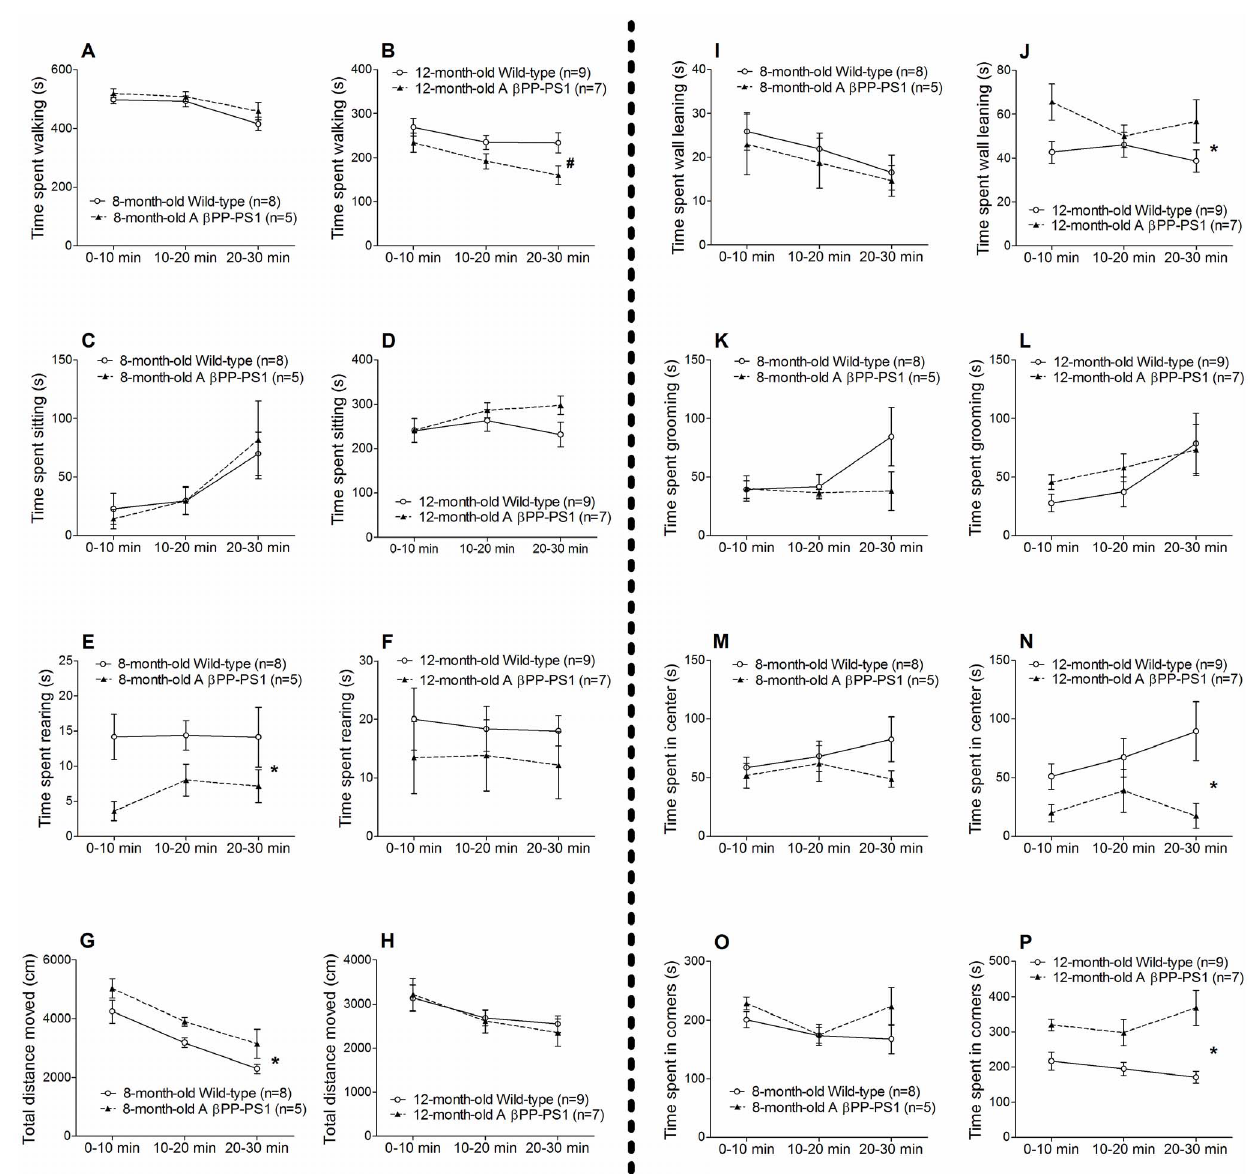
Figure 5. Open field behavior in A b PP-PS1 and wild-type mice at 8 and 12 months of age. Different open field parameters were measured within a 30 min period, and analyzed in three 10 min trial blocks. A and B: A b PP-PS1 mice (n=5) did not differ from wild-type mice (n=8) at 8 months of age (A), but spent slightly less time walking than wild-type mice at 12 months of age, # trend p =0.058 (B). C and D: The duration of sitting was similar among wild-type and A b PP-PS1 mice at 8 (C) and at 12 months of age (D). E and F: A b PP-PS1 mice spent less time rearing than wild-type mice at 8 months of age, * p , 0.05 (E), but did not differ from wild-type mice at 12 months of age (F). G and H: A b PP-PS1 mice traveled a longer distance than wild-type mice at 8 months of age, * p , 0.05 (G), but did not differ from wild-type mice at 12 months of age (H). I and J: The duration of wall leaning was similar among wild-type and A b PP-PS1 mice at 8 months of age (I), but was increased in A b PP-PS1 mice at 12 months of age, * p , 0.05 (J). K and L: Both at 8 (K) and 12 months of age (L), the time spent grooming was similar among wild-type and A b PP-PS1 mice. M and N: A b PP-PS1 mice did not differ from wild-type mice at 8 months of age (M), but spent less time in the center of the open field than wild-type mice at 12 months of age, * p , 0.05 (N). O and P: A b PP-PS1 mice (n=7) spent more time in the corners of the open field than wild-type animals (n=9) at 12 months of age, * p , 0.05 (P), but did not differ from wild-type at 8 months of age (O). doi:10.1371/journal.pone.0063643.g005 learned to find the location of the hidden platform faster than the A b PP-PS1 mice, indicated by a significant time*genotype inter- action ( p = 0.009). Overall escape latencies tended to differ between wild-type and A b PP-PS1 ( p = 0.060) at 8 months of age, although it did not reach statistical significance. Especially on day